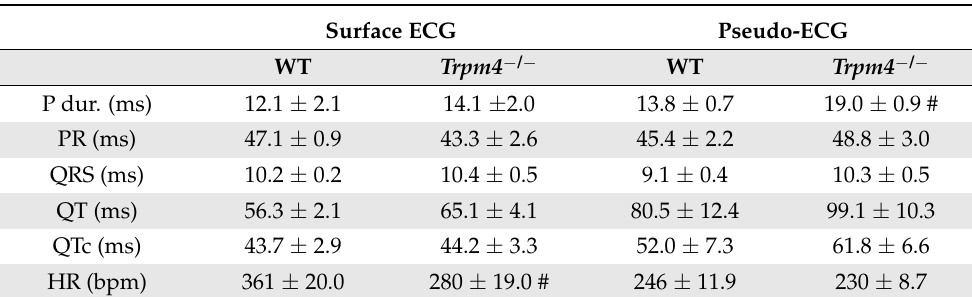
Table 3. Summary of surface and pseudo-ECG parameters from anesthetized mice. Note: #: p ≤ 0.05, WT vs. Trpm4 − / −